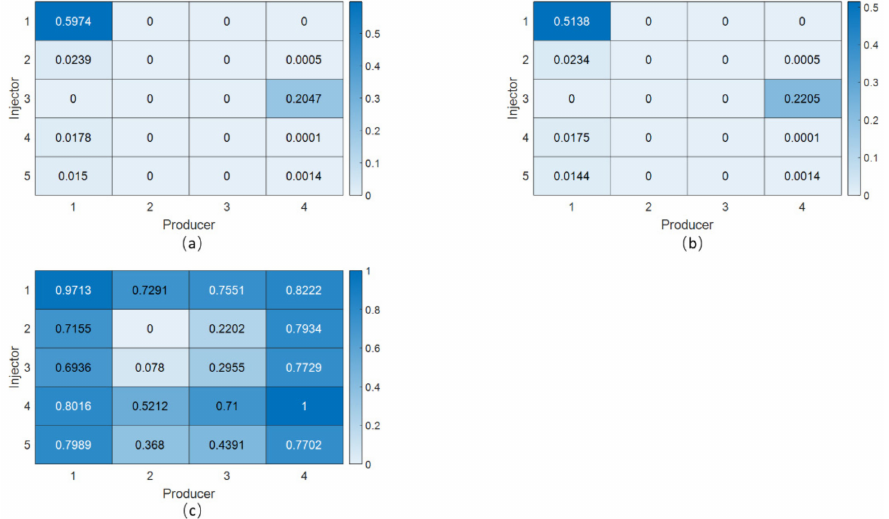
Figure 8. The heatmaps of the inter-well connectivity analysis by three models for the streak reservoir case: ( a ) KINN-tansig; ( b ) KINN-Gaussian; ( c ) SLFNN.